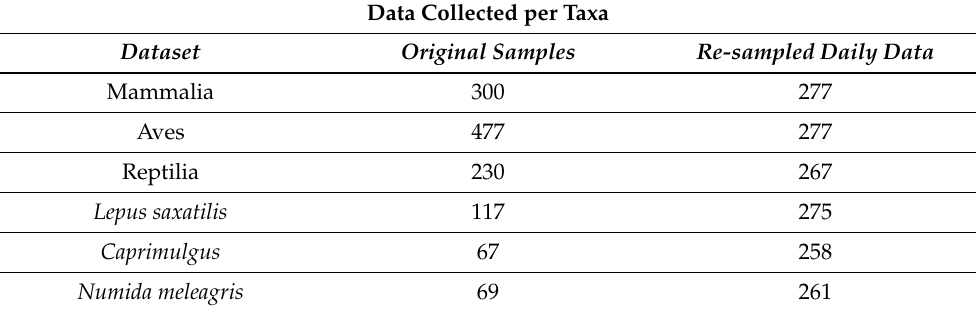
Table 1. Original and Re-sampled